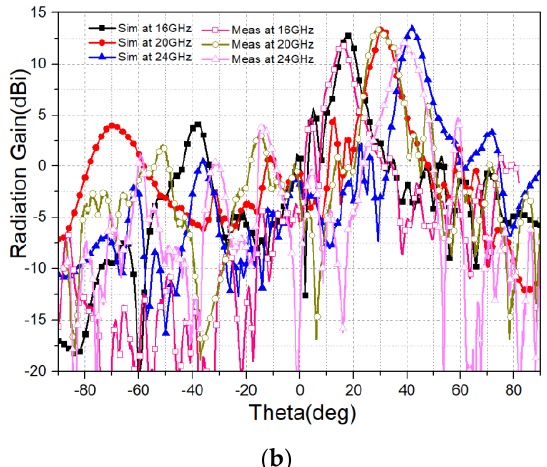
Figure 12. Simulated and measured radiation patterns of the SSPP LWA. ( a ) Simulated and measured radiation patterns at 8 GHz, 10 GHz and 12 GHz. ( b ) Simulated and measured radiation patterns at 16 GHz, 20 GHz and 24 GHz.